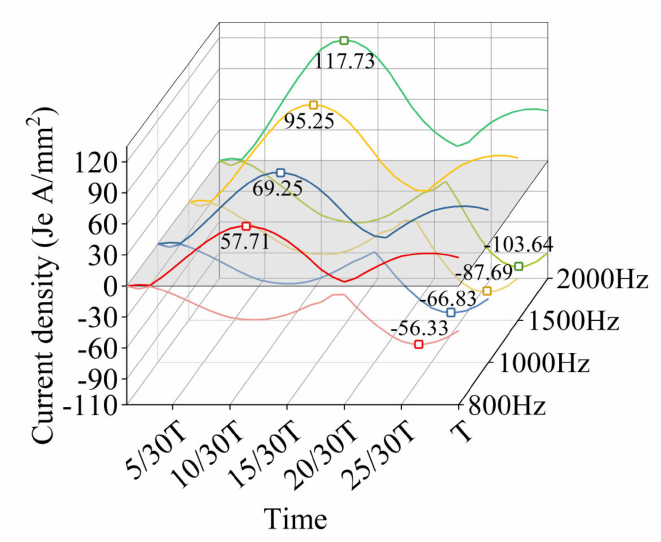
Figure 4. Maximum current density in one period at different